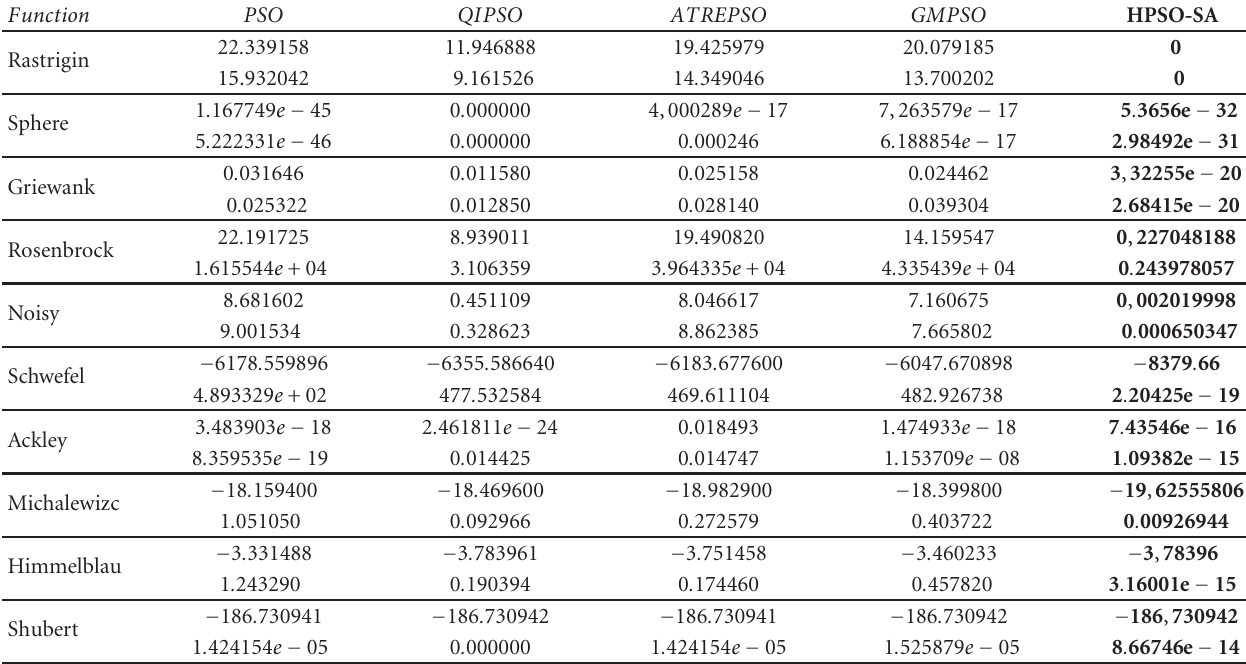
Table 3: Comparison of mean/standard deviation of solutions obtained by using hybrid HPSO-SA algorithm and approaches described in